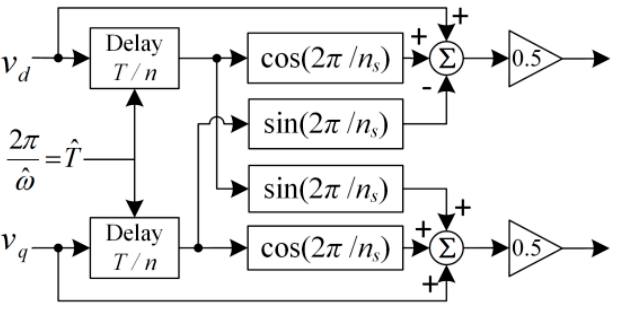
Figure 5. Time-domain implementation of the MDSC.